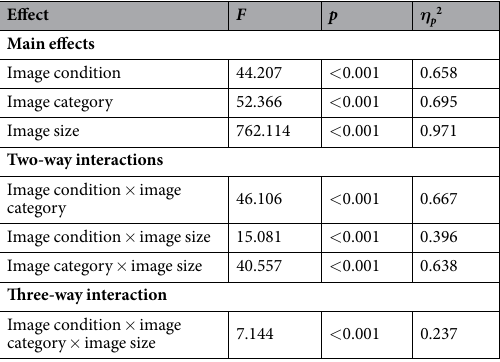
Table 2. Results of the 2 × 3 × 5 (image condition × image category × image size) ANOVA for the central tendency in the horizontal